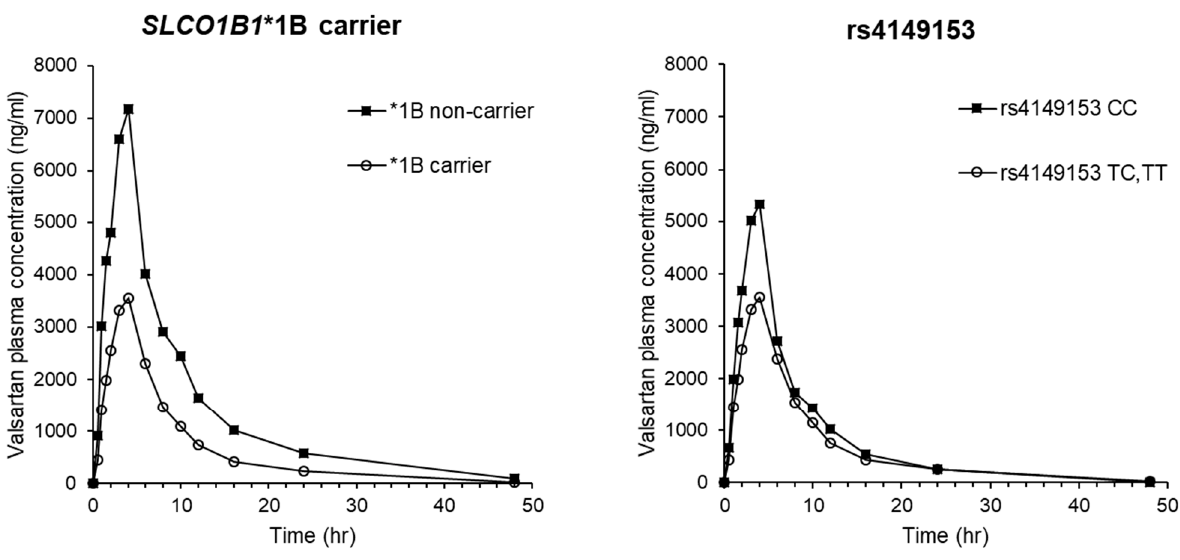
Figure 1. Mean plasma concentration-time profiles of valsartan after a single oral dose of valsartan in 25 healthy Korean male participants with SLCO1B1 *1B haplotypes and rs4149153 in SLCO1B3 .